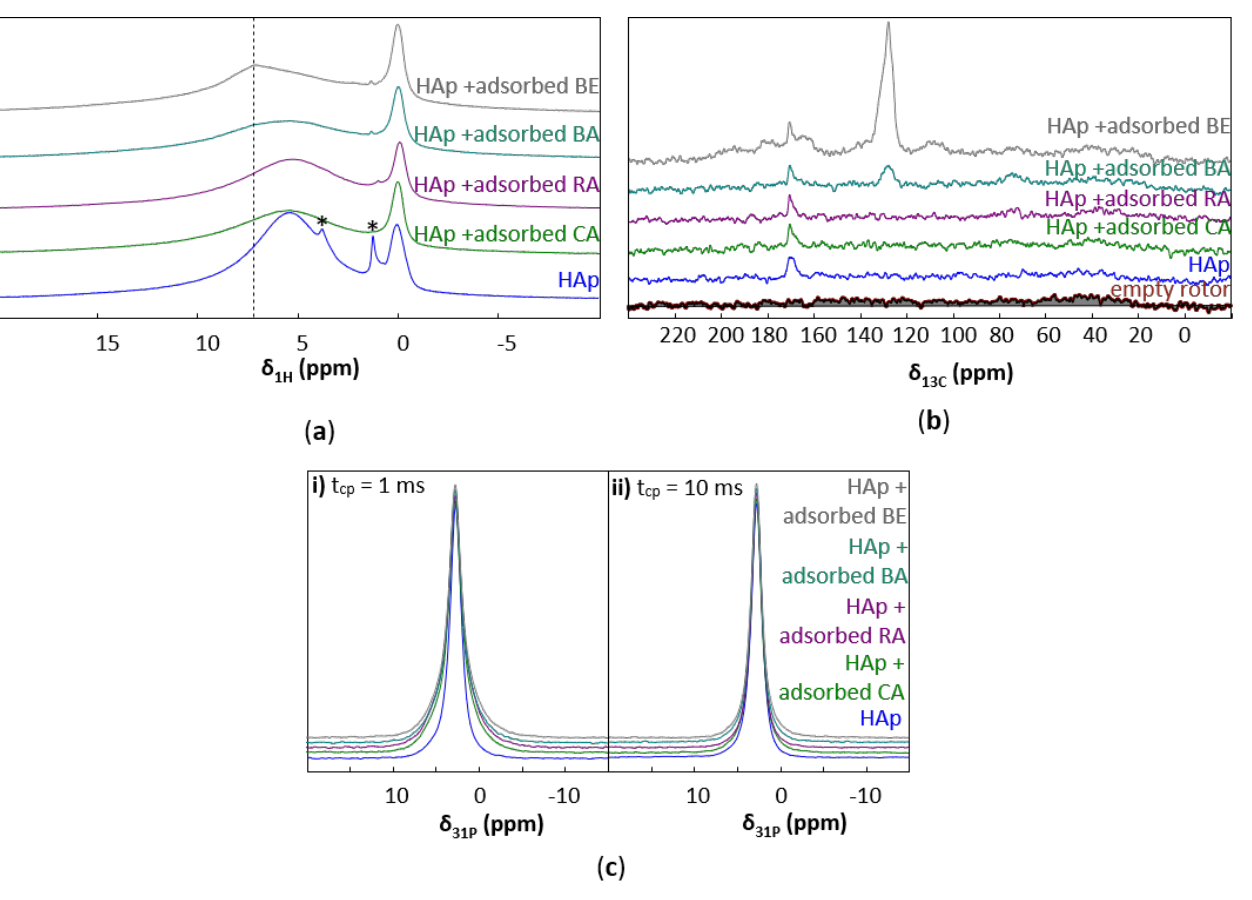
Figure 4. Solid-state NMR experiments performed on pure HAp NPs, HAp-RA, HAp-CA, HAp-BA, and HAp-BE (initial concentration for adsorption = 0.05 mM) (* indicate residual peaks of acetone and ethanol). ( a ) 1 H; ( b ) { 1 H}- 13 C CP; ( c ) { 1 H}- 31 P CP spectra at tcp = (i) 1 and (ii) 10 ms.